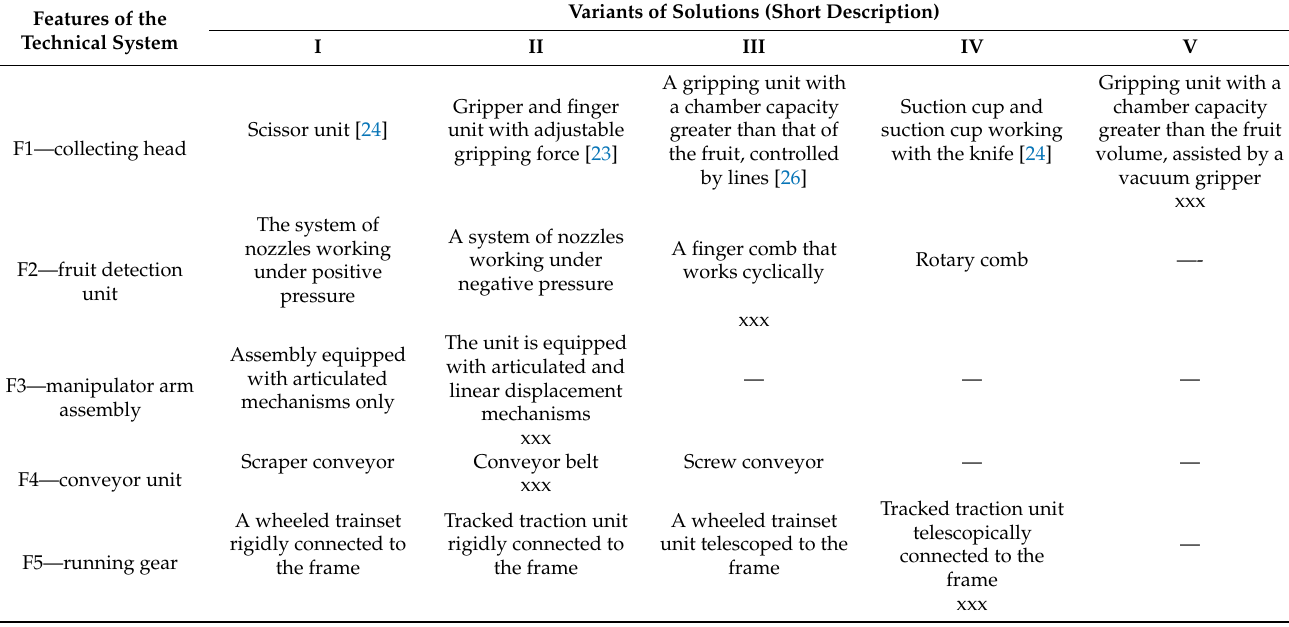
Table 1. Morphological table: optimal solutions for the construction of working units of the section for harvesting strawberry fruit in field crops and under